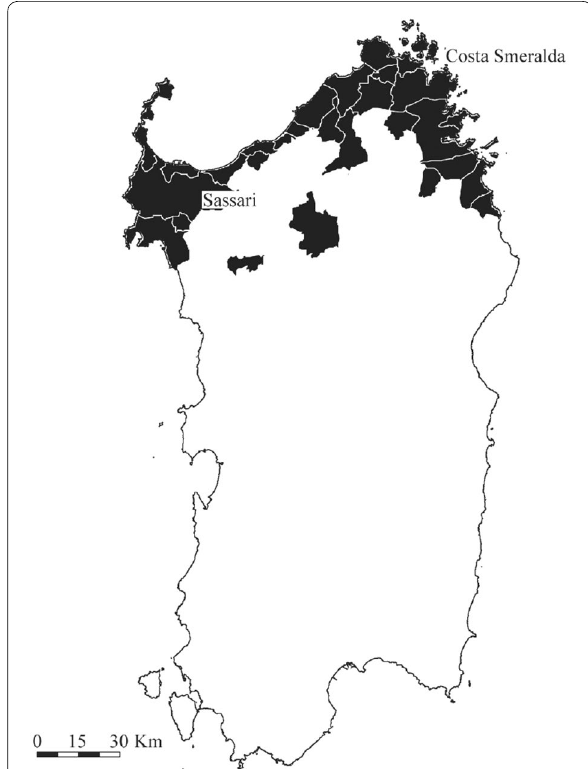
Fig. 3 Map of municipalities (in black) with the concentration of tourist arrivals (Source: Elaboration from Istat